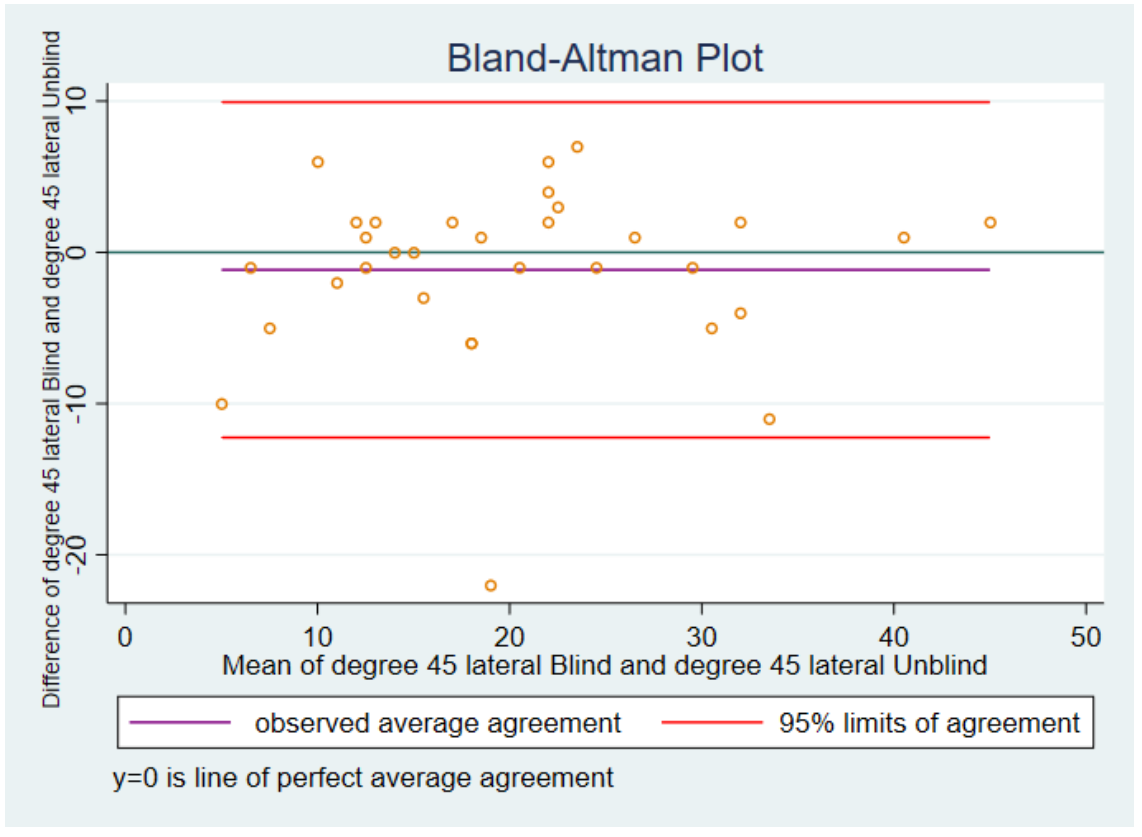
Figure A5. 45 degrees, lateral.